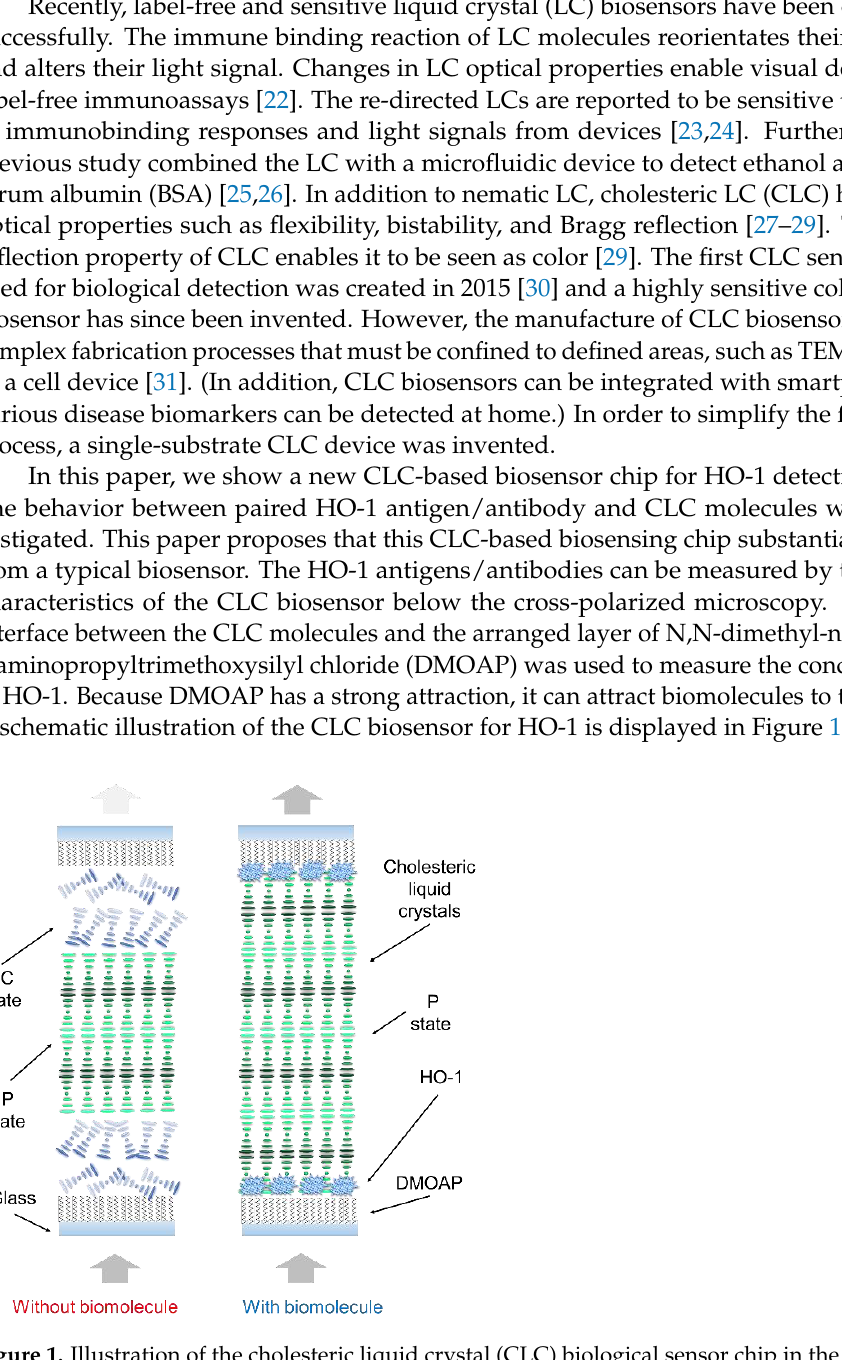
Figure 1. Illustration of the cholesteric liquid crystal (CLC) biological sensor chip in the presence of heme oxygenase (HO)-1 biomolecules in the DMOAP-coated cell. Different color arrows indicate the different light penetration